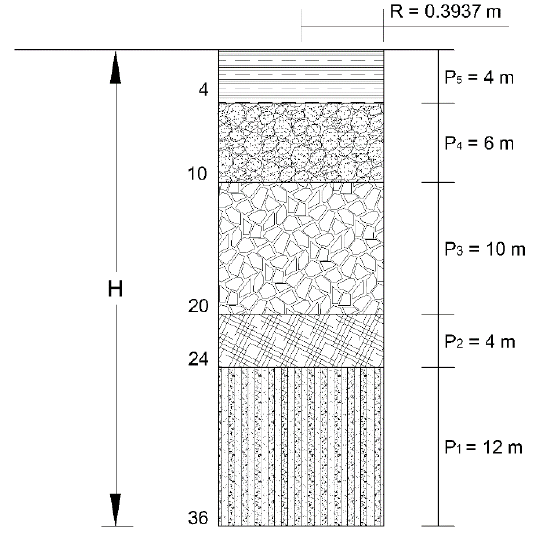
Figure 1. Simplified well scheme.